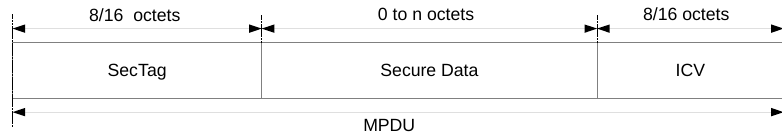
Figure 4. MACsec frame format.